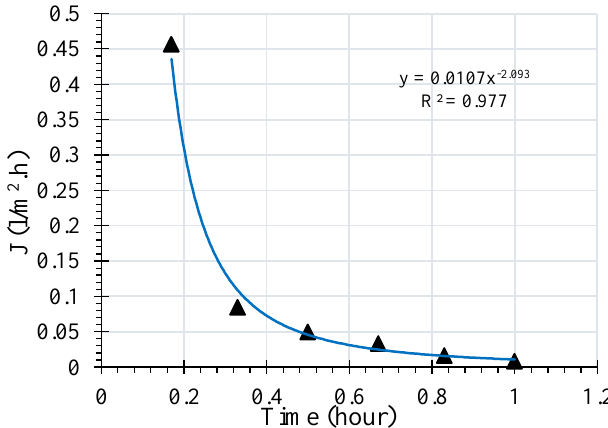
Figure 3. Variation of the permeate flux with time.